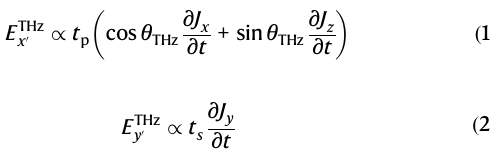
Fig. 1 | The Photo-induced THz emission in FAPbI3. a Transient photocurrent distribution and induced THz radiation of HOIPs thin fi lm under femtosecond (fs) laser excitation. xyz and XYZ represent the crystal and laboratory coordinate. θ is incident angle, Φ is the azimuth angle of sample, and J x , J y and J z are the photo- current components generated by pump light irradiation on sample, respectively; b THz time-domain emission spectraof 0.95FA measured with different excitation